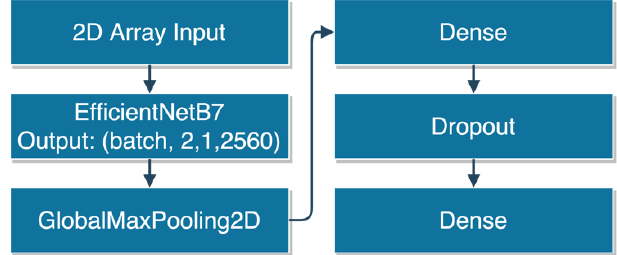
Figure 18. Implementation of EfficientNetb7 from TensorFlow library.